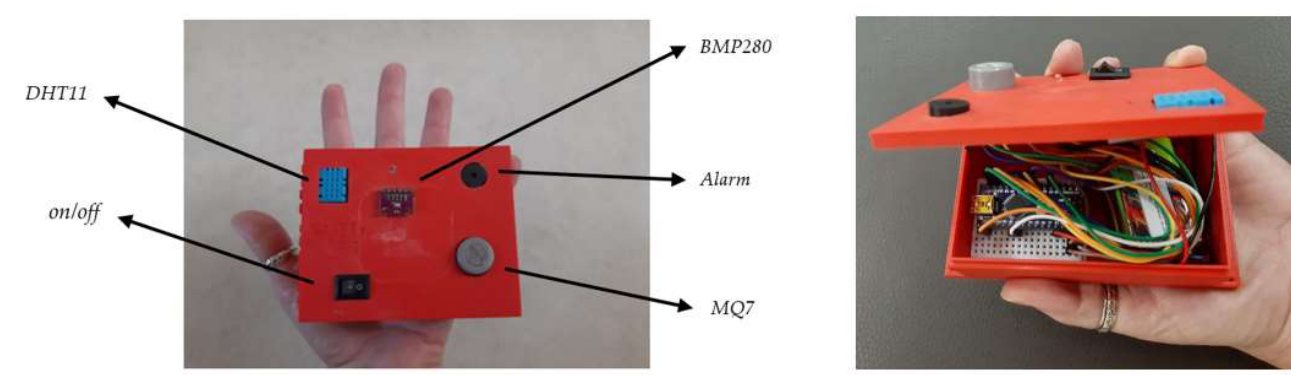
Figure 1. The wearable monitoring device prototype.